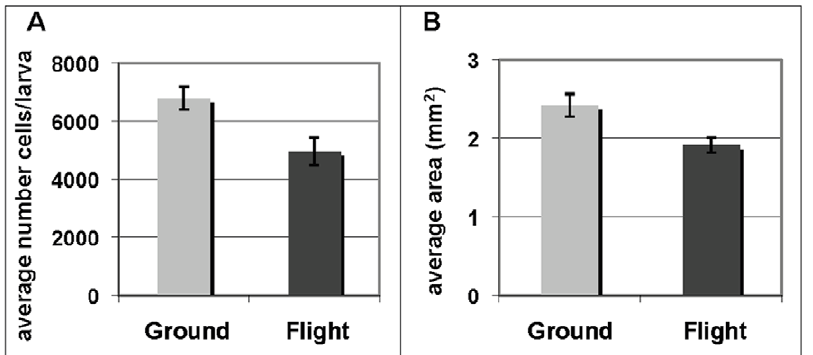
Figure 1. Space-reared larvae have fewer plasmatocytes and are smaller. A. The average number of plasmatocytes per larva was significantly reduced in flight vs ground ( p -value , 0.008, n=20). B. Larvae reared in space were significantly smaller than ground-reared larvae ( p - value , 0.0085, n=10).